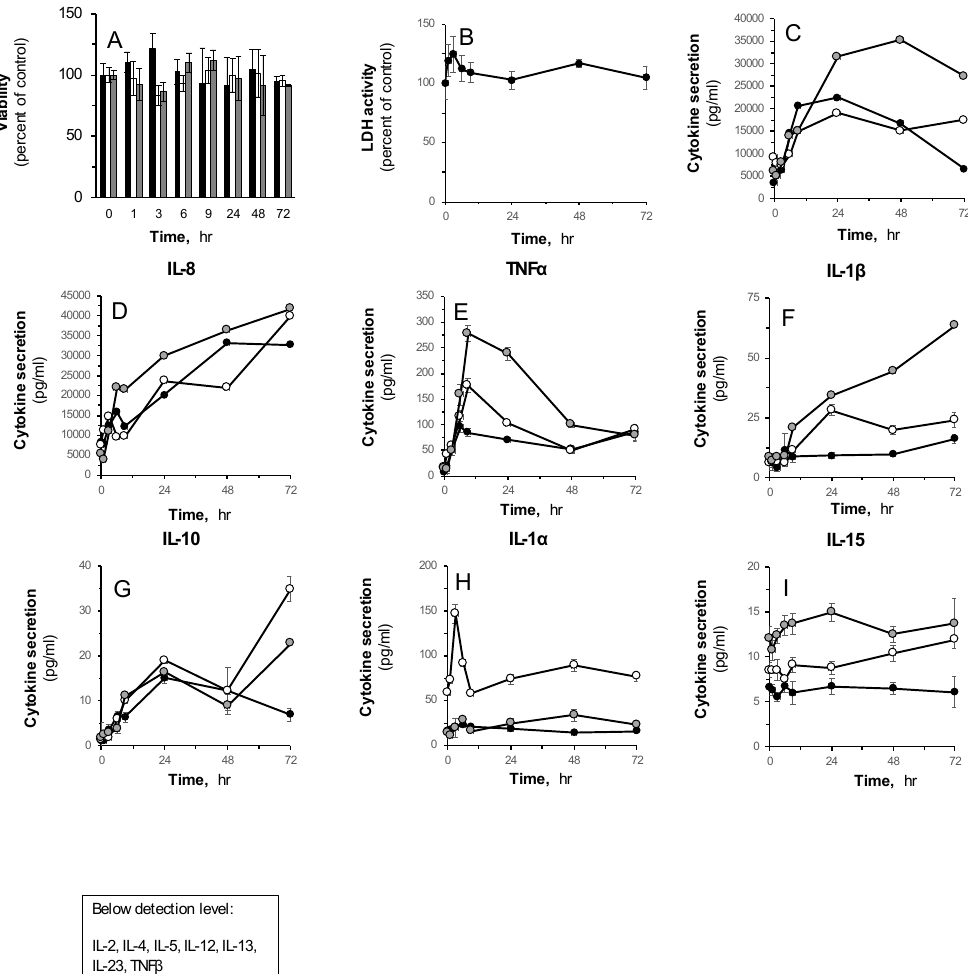
Figure 2. Time-dependent impact of LPS on cytokine secretion levels in the human skin organ culture. The skin explants were treated without or with LPS ((1) E.coli O111:B4; 5 µ g / mL) at the indicated time points. A : The epidermal layer was taken for viability test by MTT assay. B : The viability of the skin organ culture was determined by LDH. C – I : the secreted cytokine levels in the human skin organ culture were quantified by multiplex. Each curve represents a different donor. Box: specified cytokines’ amounts were below detection levels. Results are presented as MEAN ± SEM, n = 3. Average skin weight was 155 mg ± 4.3, without any impact of the treatment.